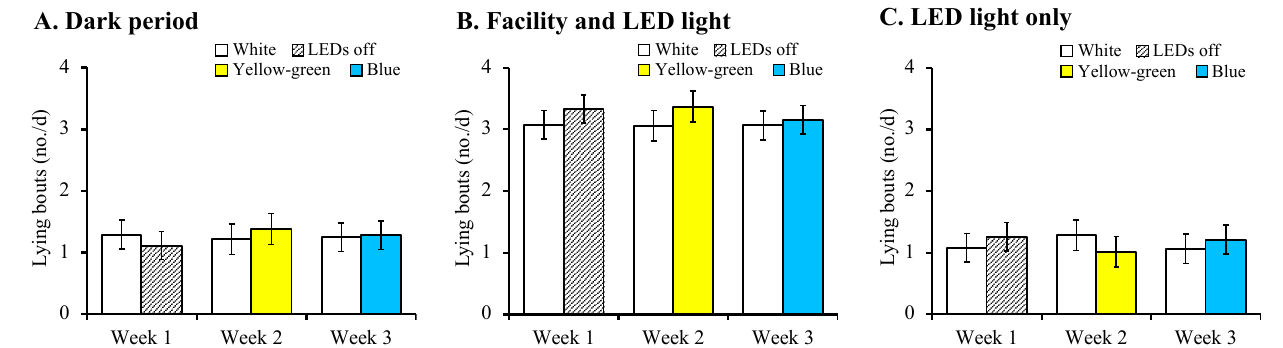
Figure 5. Least square means ± SE for number of lying bouts during the dark period ( A ), facility and LED lighting period ( B ), and LED light only period ( C ). Fourteen lactating dairy cows given free access to two different LED light options each week in a three-week preference test. White light had a spectral distribution of 380–780 nm (full-spectrum), yellow-green light had a wavelength of 564 nm, and blue light had a wavelength of 483 nm. The white lights tested in weeks 2 and 3 were adjusted to a lux similar to that of the colours tested. Weeks were comprised of 3 days of no light (adaptation) and 4 days of treatments. To account for the facility lighting, the number of lying bouts was analysed in each time period. The dark period was from 0000 to 0400 h, the facility and LED light period was from 0400 to 2000 h, and the LED light only period was from 2000 to 0000 h.